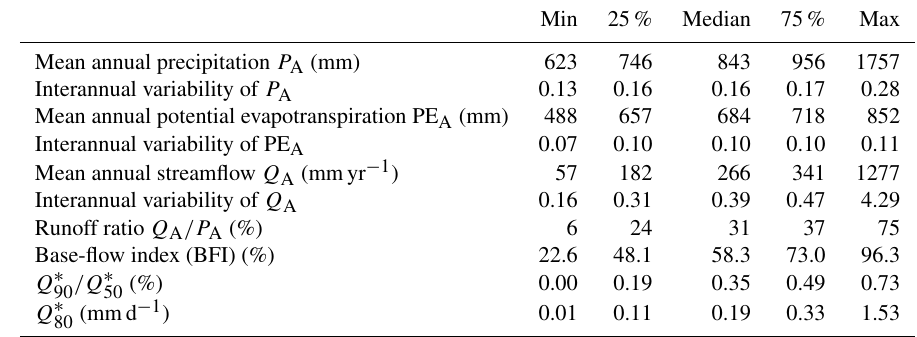
Table 2. Percentiles of the distribution of a few climatic and hydrological characteristics of the 118 catchments. Interannual variability values correspond to coefficients of variation calculated on the 1958–2009 period for P and PE, and on streamflow available period for Q . Q 50, Q 80 and Q 90 are respectively the 50th, 80th and 90th exceedance percentiles of the flow duration curve.